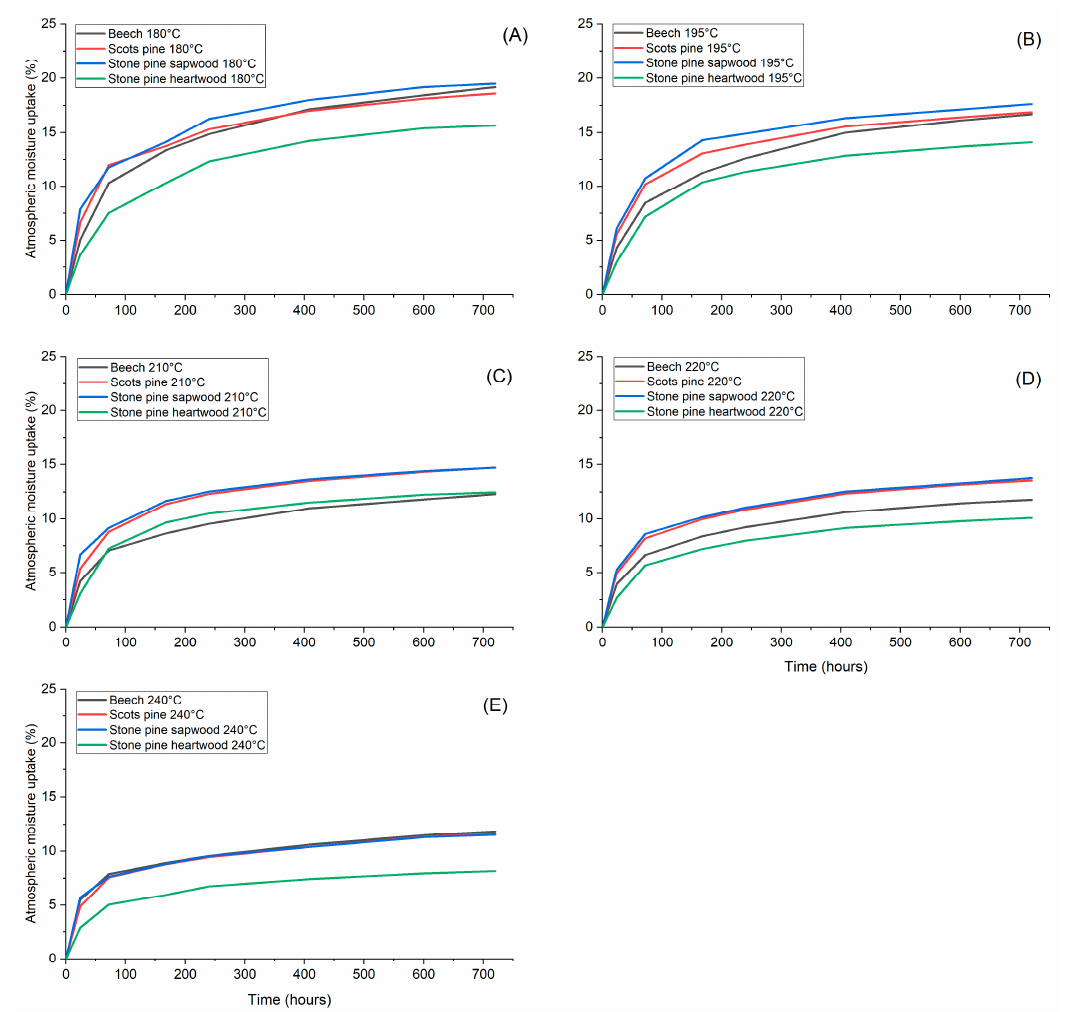
Figure 4. Relationship between maximum heat treatment temperatures and water absorption from ambient air for samples placed above water in a glass chamber (RH = 98% ± 2%): 180°C (A), 195°C (B), 210°C (C), 220°C (D), 240°C (E).